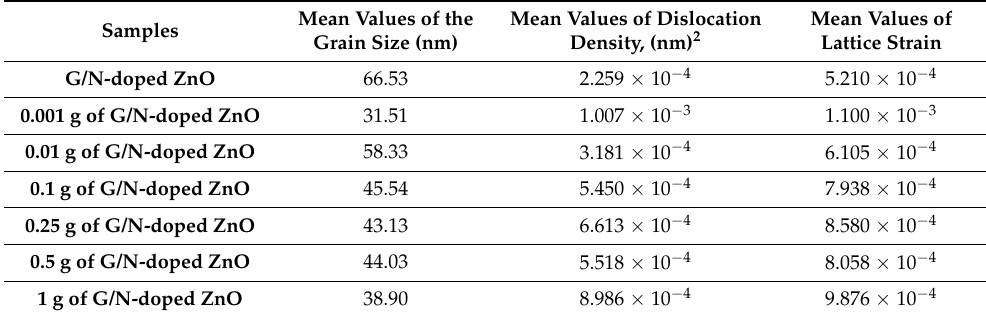
Table 1. The computed mean values of the grain size ( D ), dislocation ( δ ), and strain ( ε ) from the XRD spectra for all prepared G/N-doped ZnO